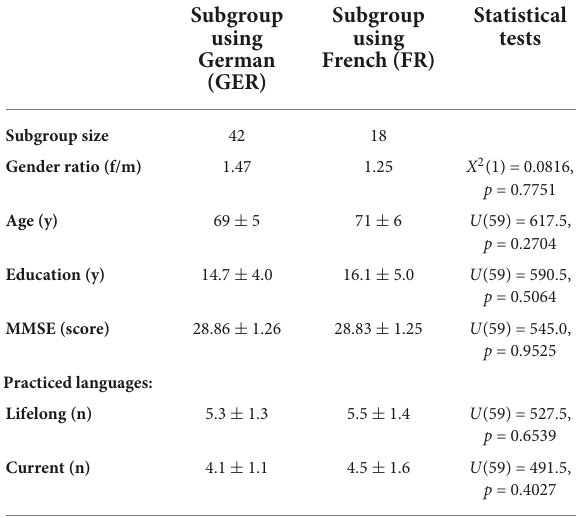
TABLE 1 Population feature differences between subgroups defined by preferred stimulus language.